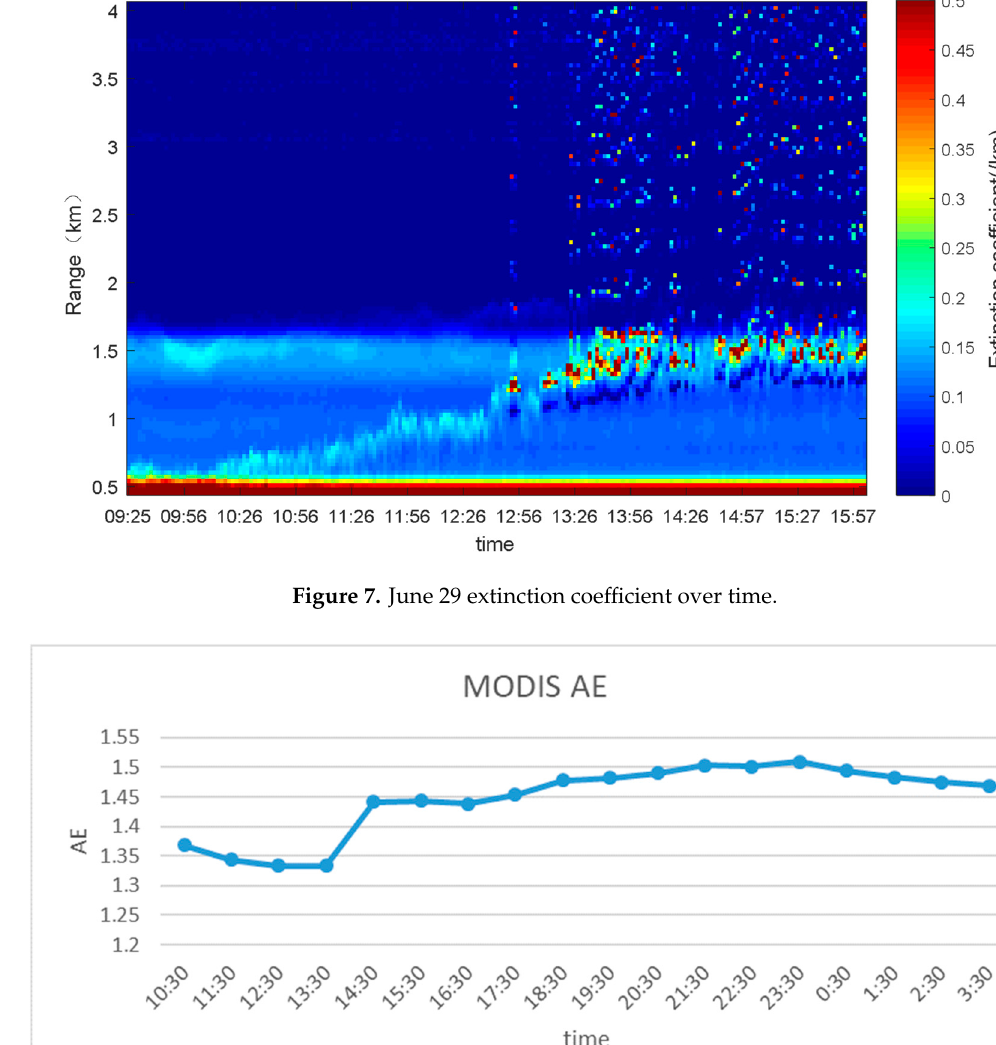
Figure 9. AOD time evolution during June 29. The extinction coefficient profile for CALIPSO transiting through Nanjing at 13:27 local time was analyzed and compared with the extinction coefficient profile retrieved by ground-based Mie-Lidar at the same time, as shown in Figure 10a. Vertical profiles with simultaneous polarization ratios, and color ratios retrieved from the CALIPSO L2APro product are shown in Figure 10b,c, respectively. S tandard errors of extinction coefficient, polarization ratio and color ratio at each altitude were